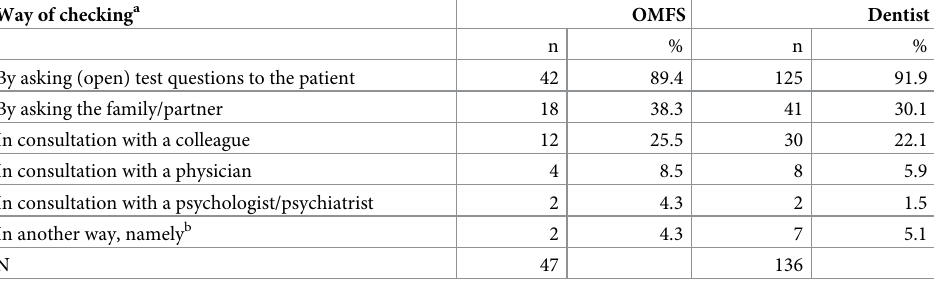
Table 2. Methods used to assess a patient’s intellectual competence concerning the most recent request for extrac- tion without a clear clinical